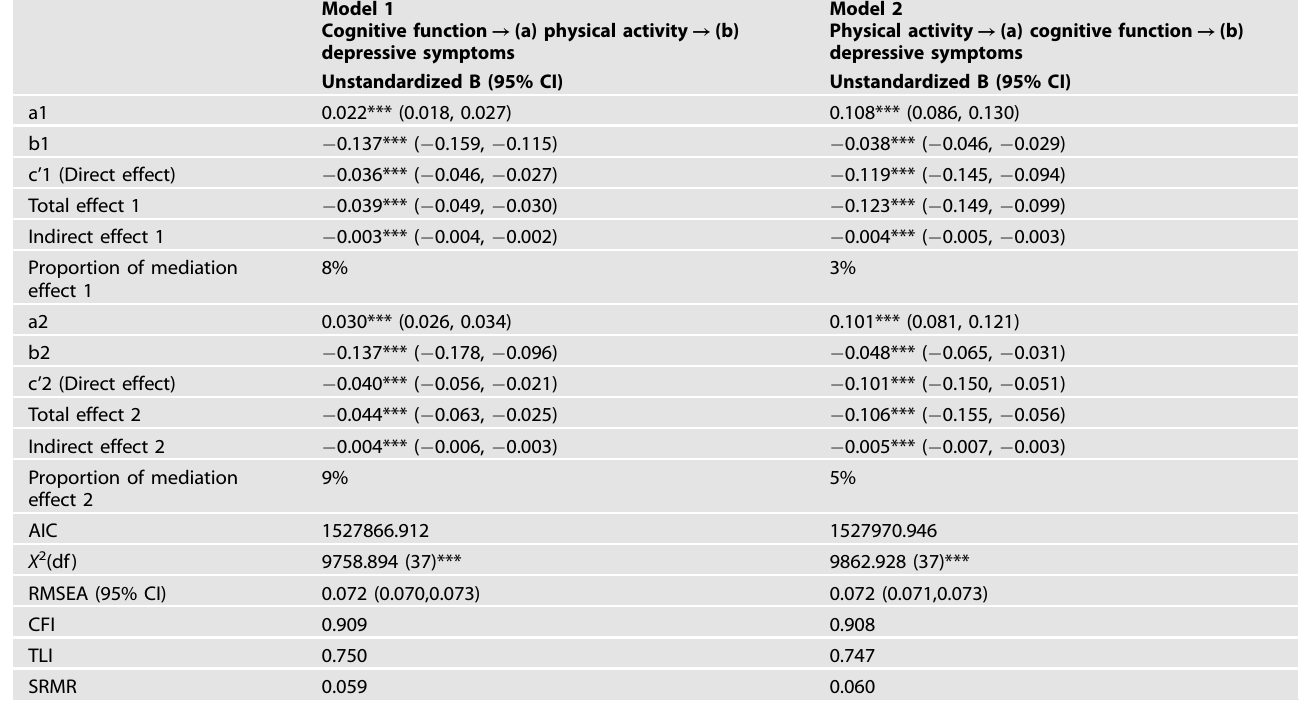
Table 3. Longitudinal mediation models ( n = 51,191). Model 1 Cognitive function → (a) physical activity →